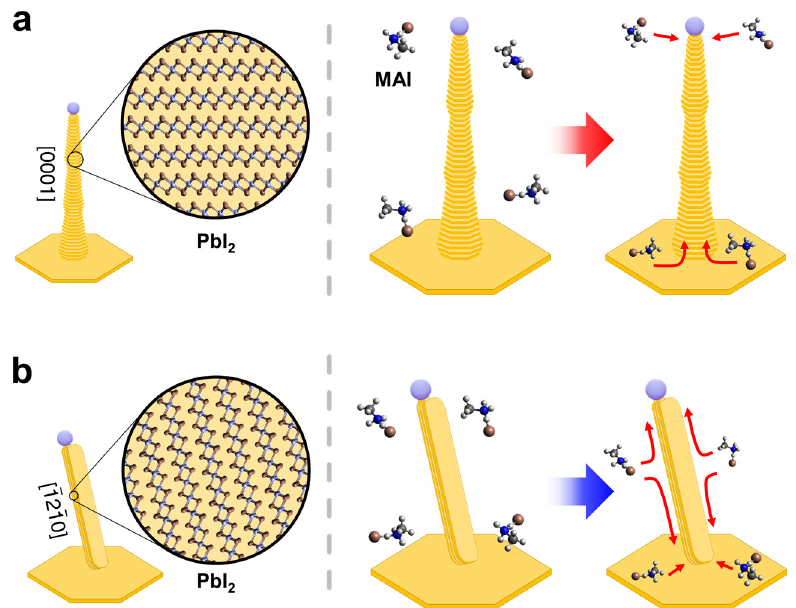
Figure 5. Schematics of vapor-phase perovskite conversion routes according to the growth direction of PbI 2 nanowires. ( a ) [0001]-oriented, vertical type A nanowire composed of axial-transverse PbI 2 layers. MAI sidewall diffusion is limited across the layers. ( b ) [ 1(cid:3364)21(cid:3364)0 ]-oriented, tilted type B nanowire with parallel PbI 2 layers along the axis. MAI diffuse along with the axial-parallel PbI 2 layers and intercalate into the ( 112(cid:3364)0 ) facets.